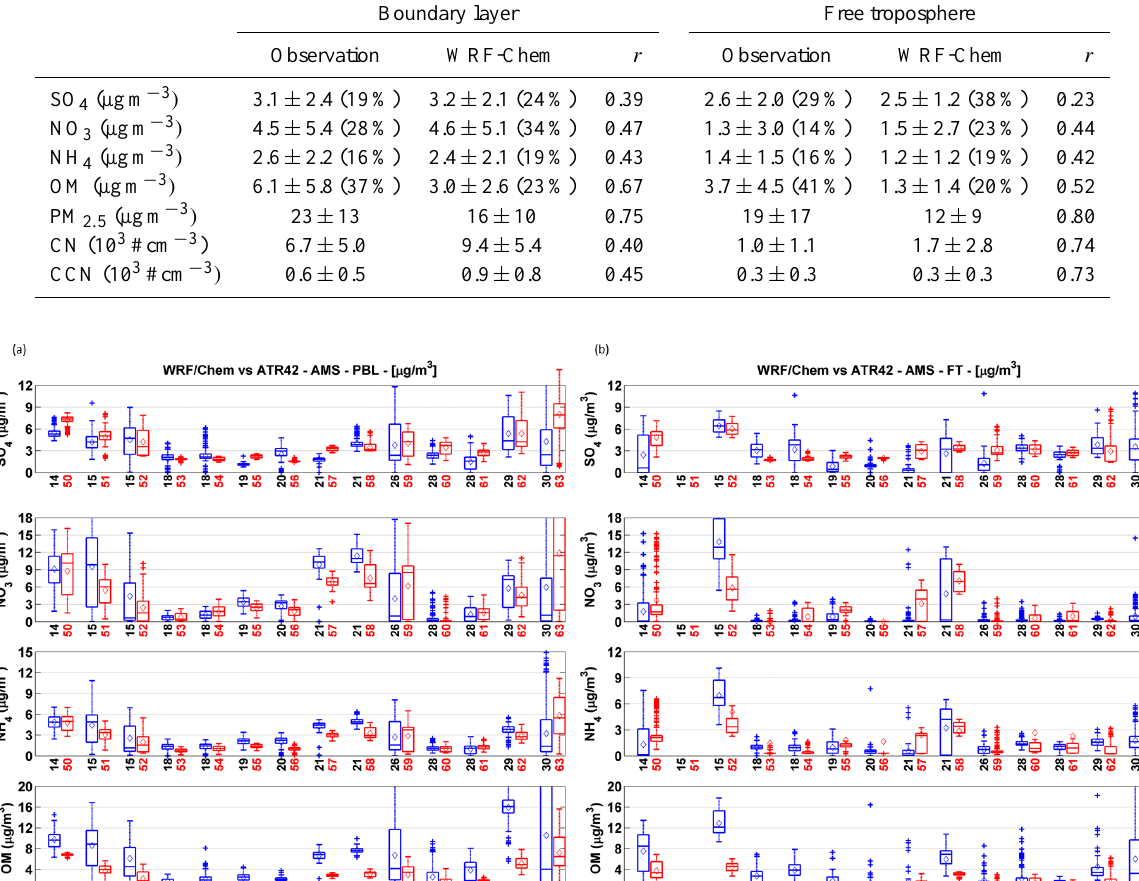
Table 3. Observed and modelled mean values, standard deviations, and relative number (expressed as percentage) of aerosol species, number of aerosol particles, cloud condensation nuclei, over the whole period of the aircraft campaign in boundary layer and free troposphere.